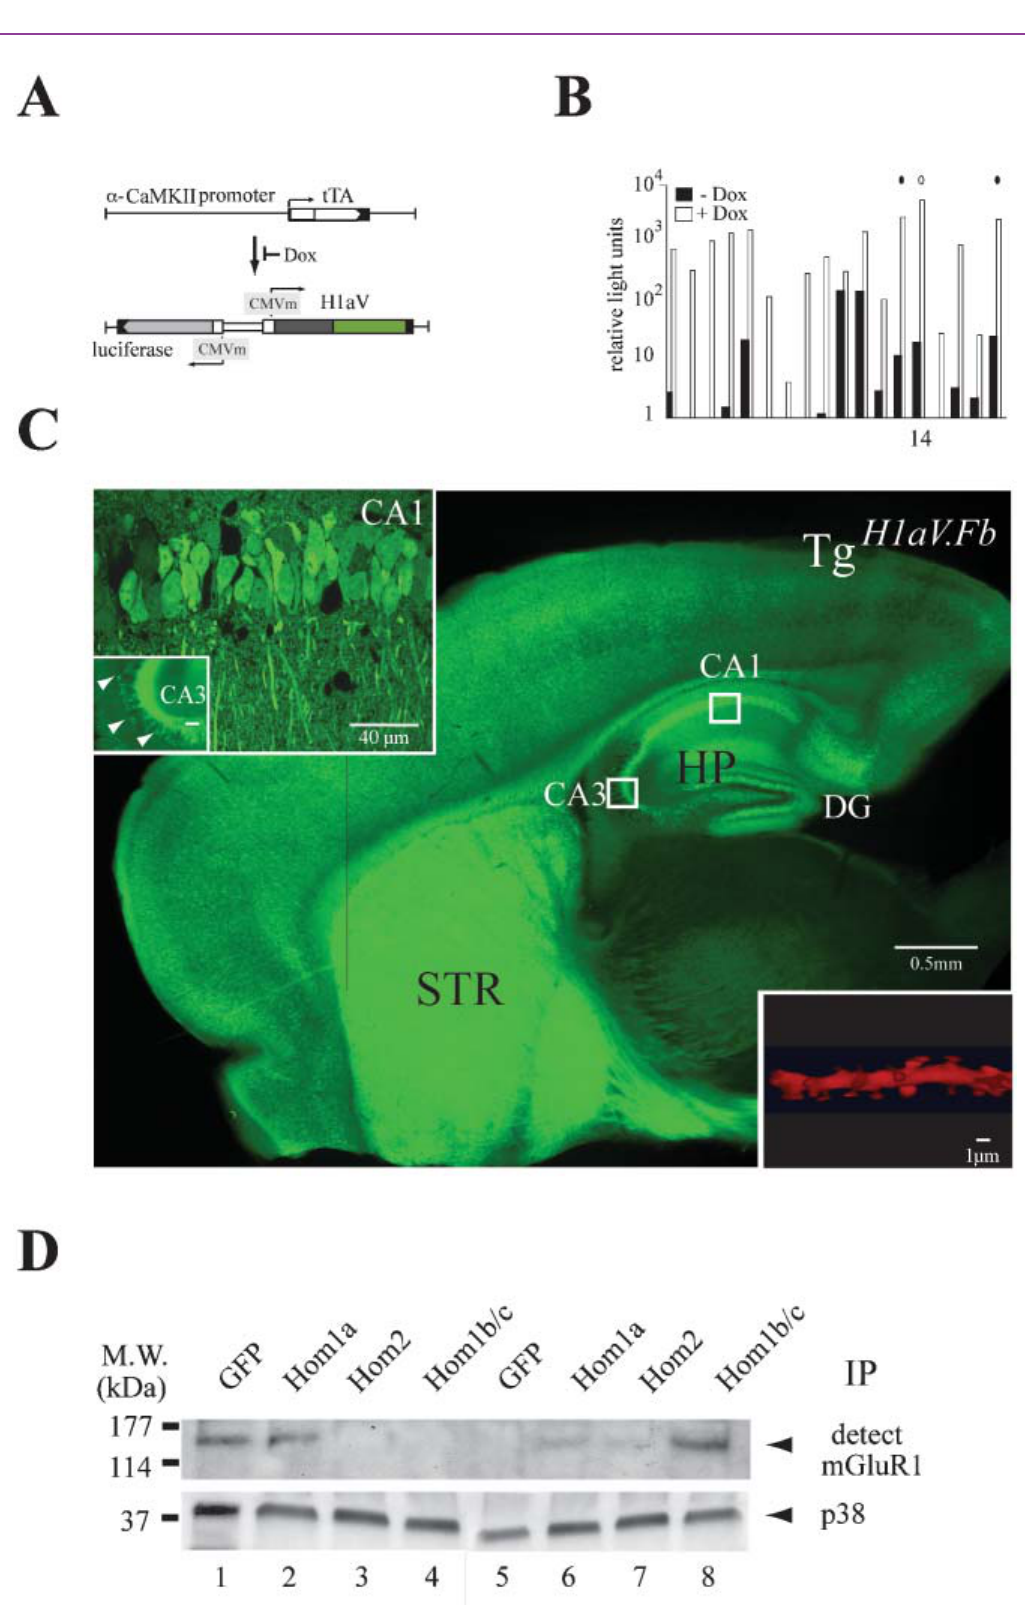
Figure 1. Tetracycline-dependent forebrain expression of H1aV . ( A ) Transgenes for tet-dependent H1aV expression in the mouse forebrain. The α -CaMKII promoter directs tTA expression in forebrain principal neurons (Mayford et al., 1996). The luciferase (luc) and H1aV genes are transcribed from a bidirectional unit activated upon binding of tTA to heptamerized tet operator sequences (tetO 7 ) flanked by CMV minimal promoters. Dox prevents tTA binding to tetO 7 , 100